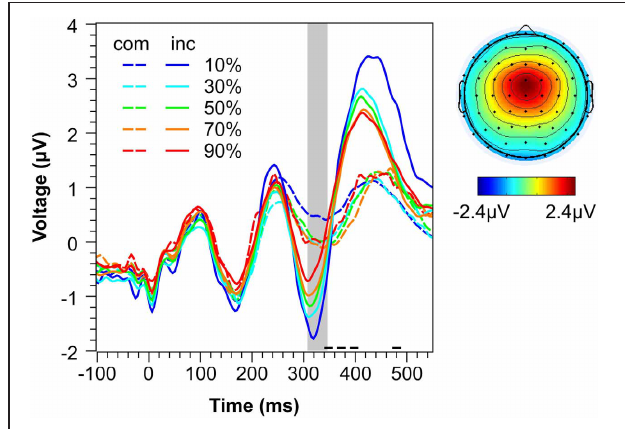
FIGURE 4 | Conflict-related IC. Left: Mean activity of the extracted ICs representing the N2 conflict effect as a function of Compatibility and Conflict Probability. The shaded area represents the time range of the N2 used for analysis. Horizontal lines at the x -axis indicate the range of mean RTs for compatible trials (long dashed line) and incompatible trials (short continuous line). Right: Mean topography of the extracted ICs. com, compatible. inc,